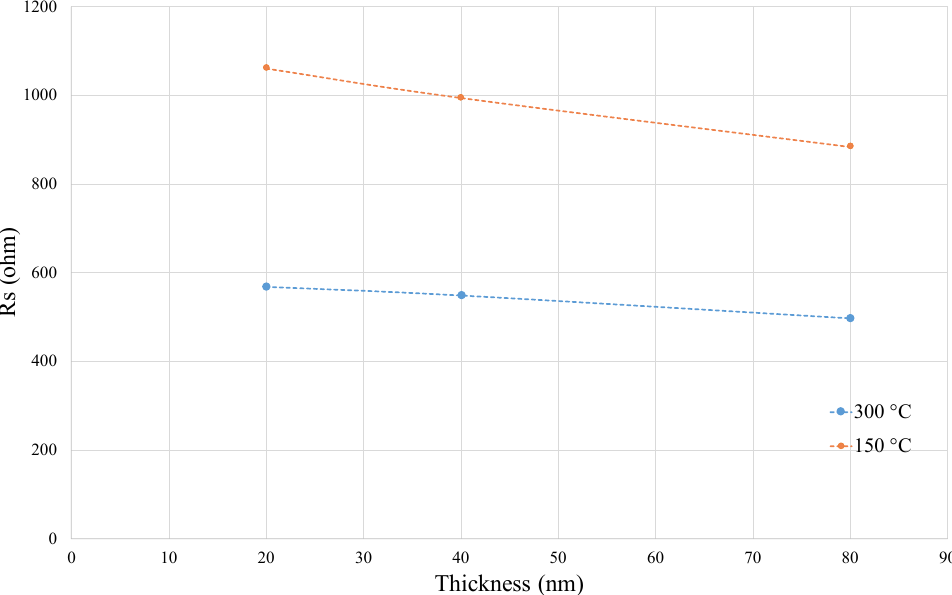
Figure 8. Series resistance versus thickness in two different